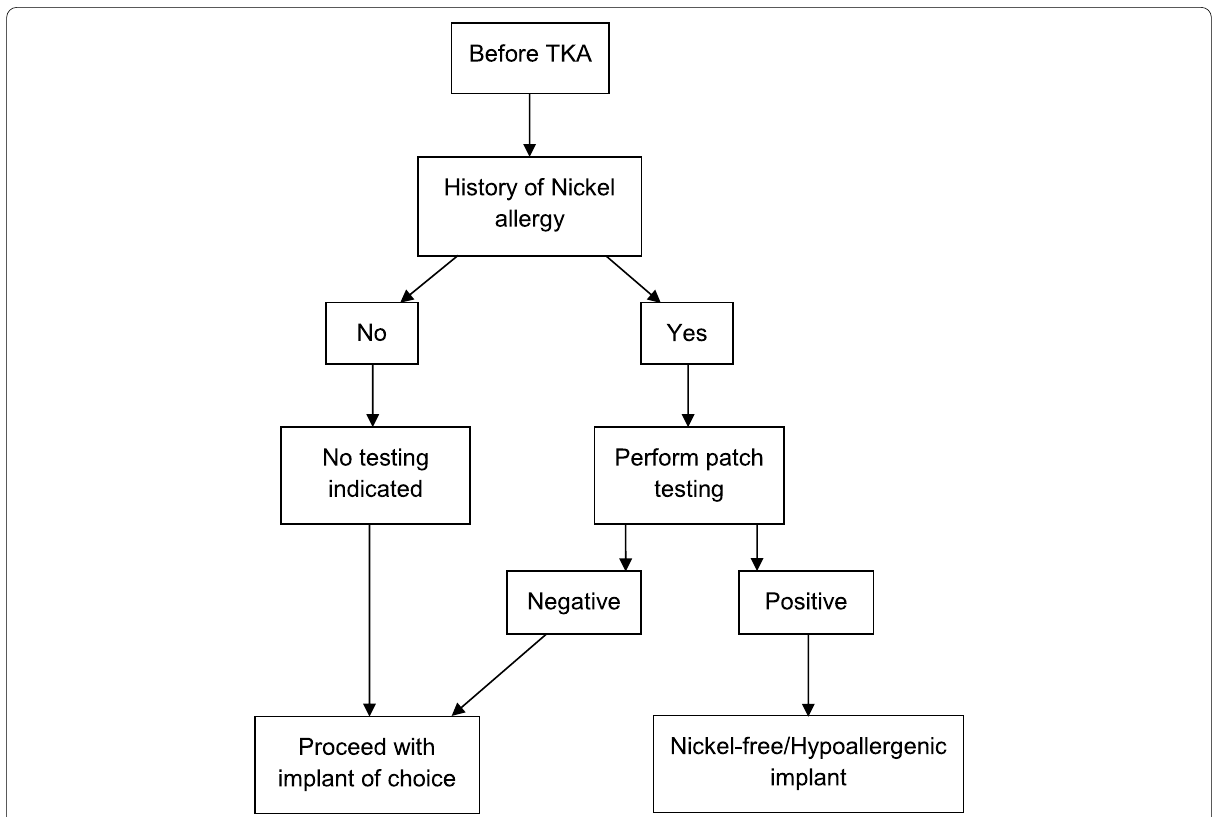
Fig. 2 Diagnostic algorithm for Nickel hypersensitivity in patients before total knee arthroplasty (TKA) (adapted from Mitchelson et al .